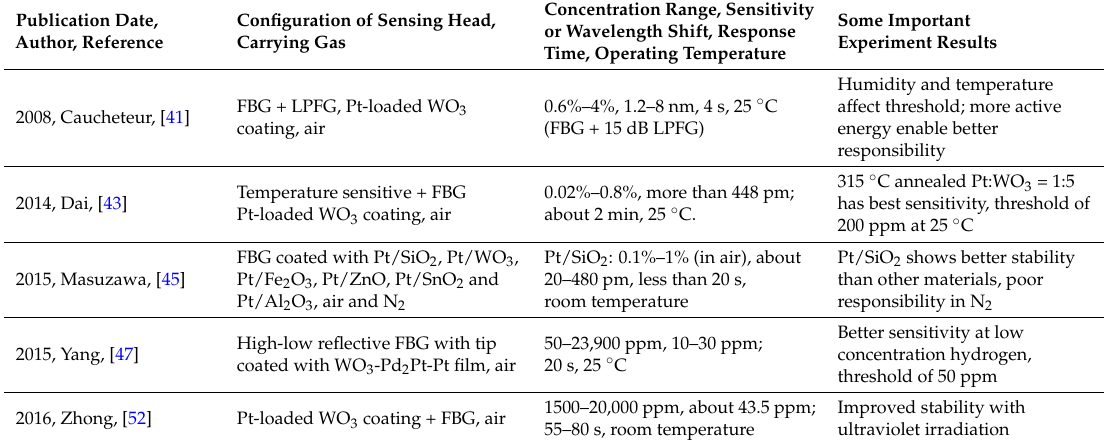
Table 2. Comparison of hydrogen sensor based on thermal reaction and gasochromic